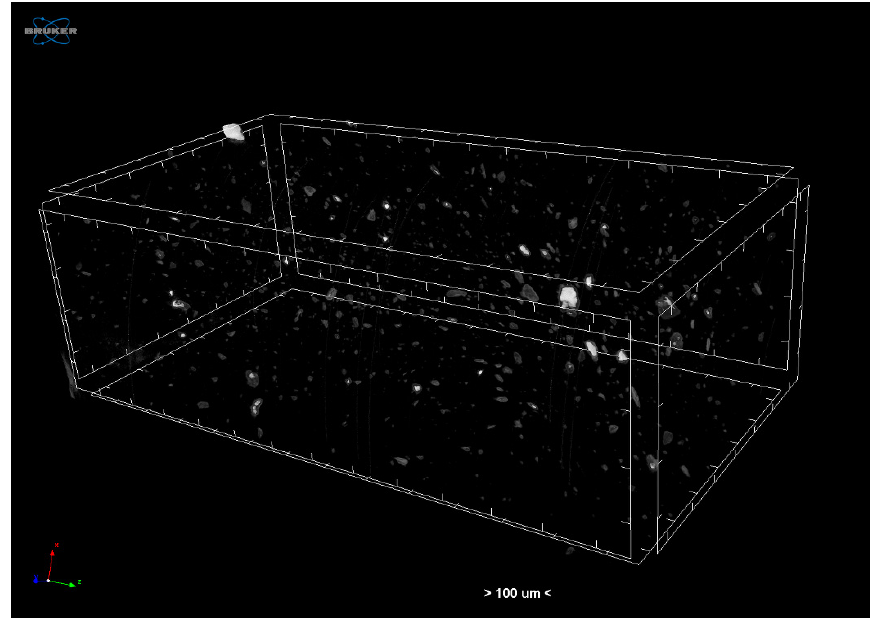
Figure 9. CT scan for MMT–GO polyurea